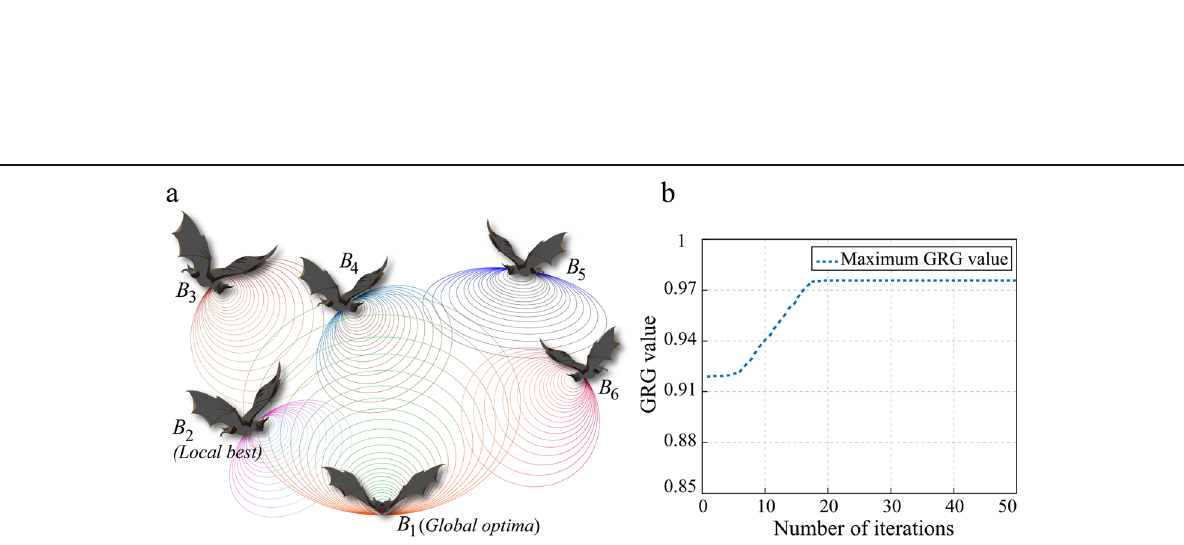
Fig. 7 Bat-inspired optimization algorithm. a The schematic diagram of bat algorithm. b Iteration process with bat